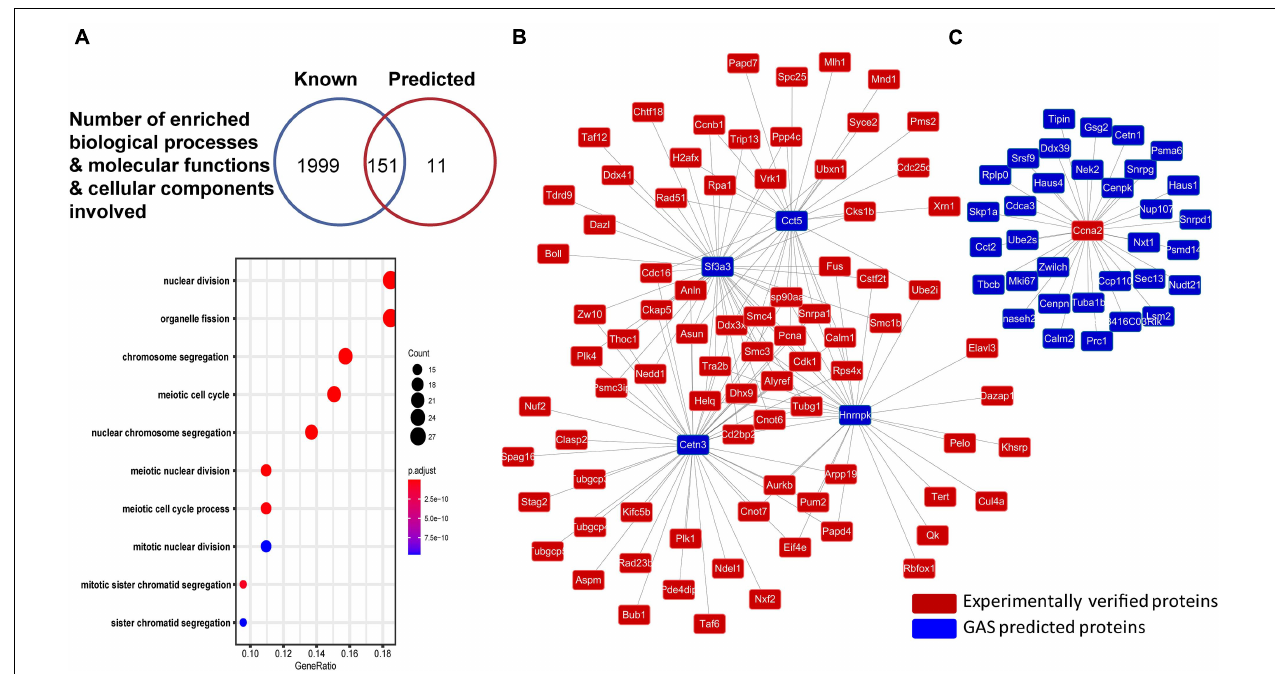
FIGURE 3 | The GO analysis and protein network in MeiosisOnline. (A) GO analysis for known and predicted genes in MeiosisOnline and GO enrichment analysis of the predicted genes. (B,C) The examples of potential protein network of meiosis analyzed by